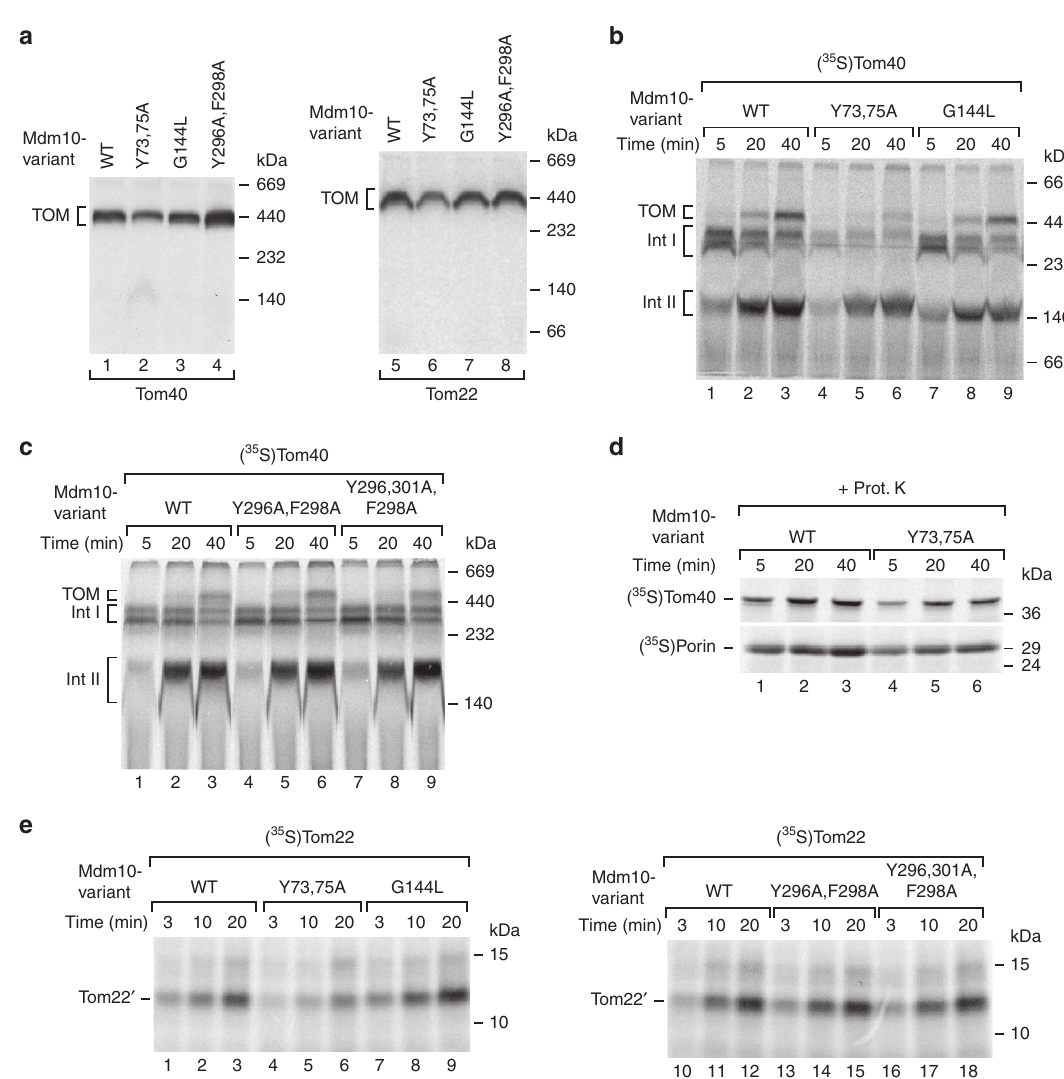
Figure 5 | Mdm10 population bound to SAM mediates biogenesis of the TOM complex. ( a ) Mitochondria isolated from cells expressing wild-type (WT) or mutant forms of MDM10 were solubilized with digitonin. Protein complexes were separated by blue native electrophoresis. The TOM complex was detected by immunodecoration with antisera against Tom40 and Tom22. ( b ) [ 35 S]Tom40 was imported into mitochondria, which were isolated from cells expressing WTor mutant forms of MDM10 , for the indicated periods. Mitochondria were reisolated, solubilized with digitonin and protein complexes were separated by blue native electrophoresis. Radiolabelled protein complexes were visualized by autoradiography. Int I/II, intermediate I/II. ( c ) [ 35 S]Tom40 was imported into isolated mitochondria as described in b . ( d ) [ 35 S]Tom40 and [ 35 S]Porin were imported into WTand Mdm10 Y73,75A mitochondria for the indicated periods. The mitochondria were treated with proteinase K and analysed by SDS–polyacrylamide gel electrophoresis and autoradiography. ( e ) [ 35 S]Tom22 was imported into WTand the indicated Mdm10 mutant mitochondria, followed by treatment with proteinase K. The protease-protected fragment of membrane-inserted [ 35 S]Tom22 (Tom22 0 ) is